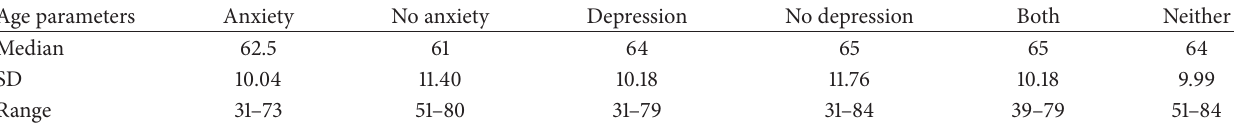
Table 1: The median age, standard deviations, and age ranges of veterans with tinnitus with/without anxiety and depression ( 𝑛 = 91 ).